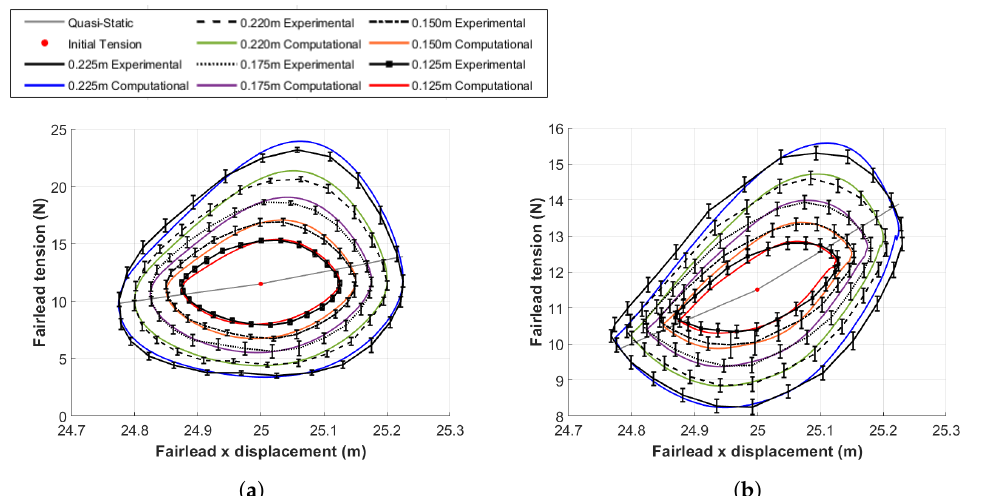
Figure 21. Comparison between the computed fairlead tension values and the experimental measure- ments of the isolated mooring line for two different oscillation amplitudes A = 0.225, 0.220, 0.175, 0.150, 0.125 m and two different periods T = 2.8, 5.5 s for the isolated mooring line. ( a ) T = 2.8 s. ( b ) T = 5.5 s.